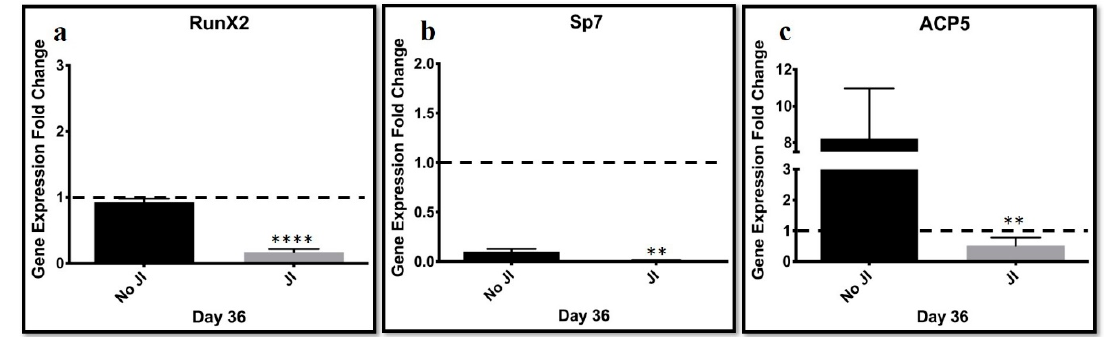
Figure 5. Bone markers gene expression is stimulated in the absence of JI1 during trans- differentiation. ( a , b ) Downregulation of Runx2 and Sp7 in the presence of JI1. ( c ) The marker ACP5 showed the highest expression (7-fold) in non-conducive media compared to the conducive conditions. ** p < 0.010.